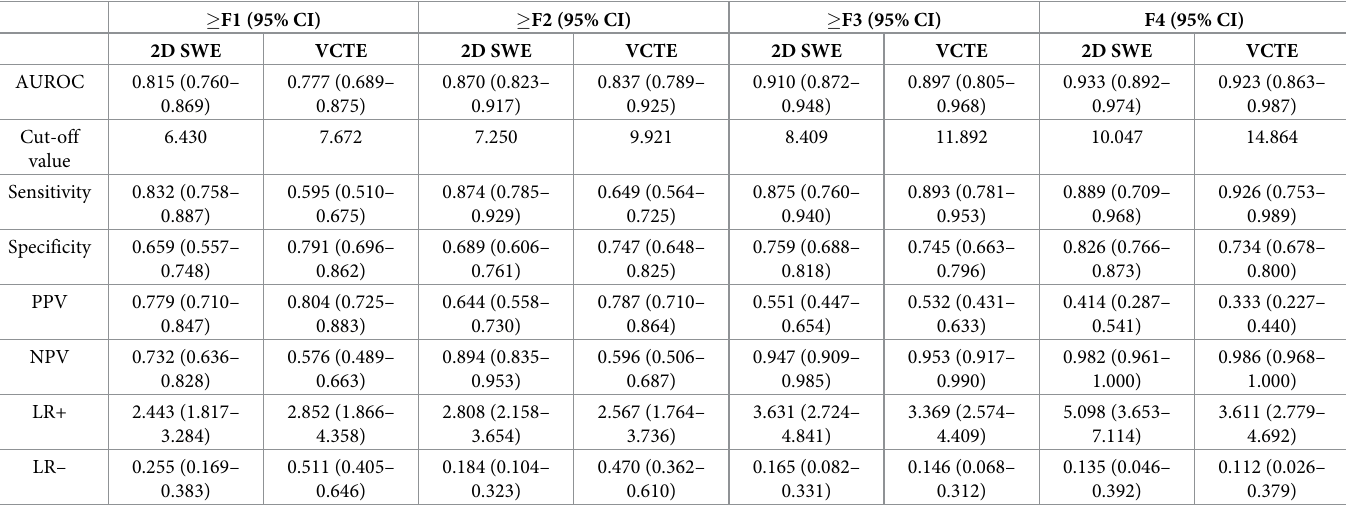
Table 2. Diagnostic accuracy of 2D SWE and VCTE for the diagnosis of fibrosis stage.